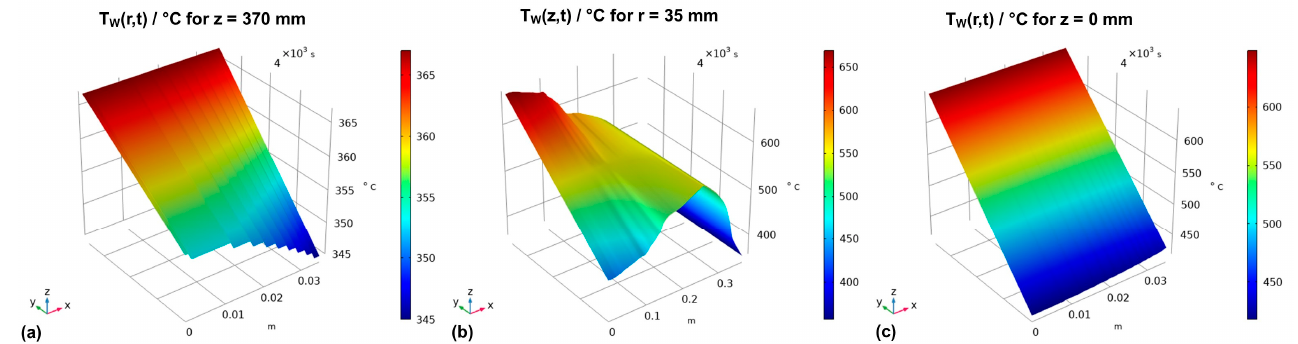
Figure 3. Thermal boundary conditions over time for ( a ) the horizontal upper outer autoclave wall, ( b ) the vertical outer autoclave wall, and ( c ) the horizontal bottom outer autoclave wall. Calculations were done using the commercial software Comsol Multiphysics. A combination of structured and unstructured mesh regions was used, as depicted in Figure 4.